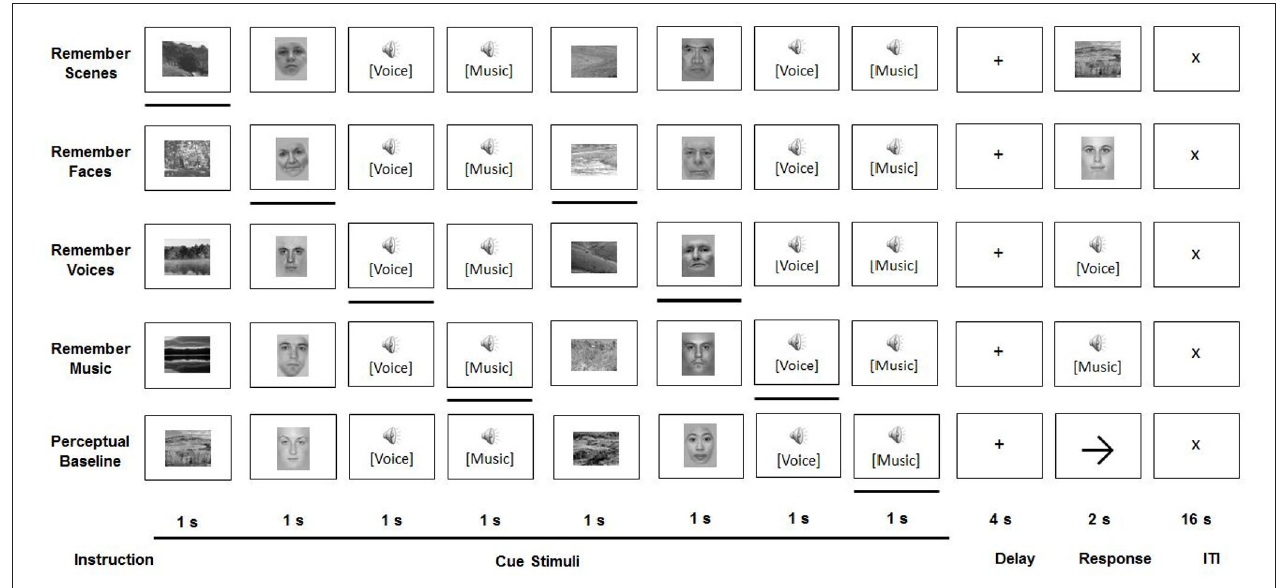
FIGURE 1 | Experimental